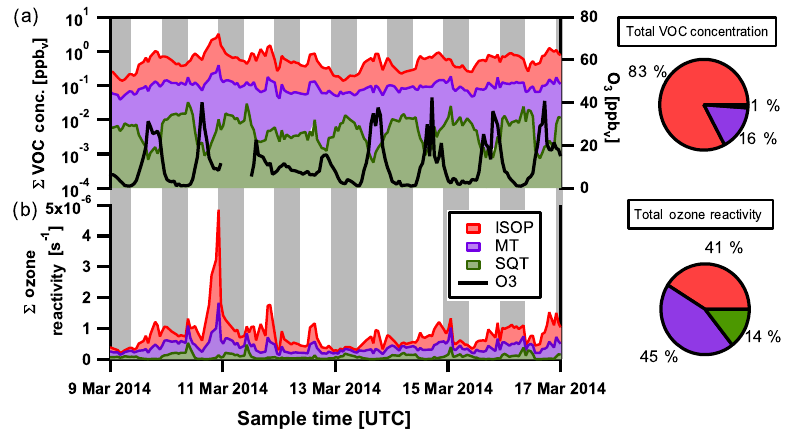
Figure 4. Wet season selected timeline of summed gas-phase VOC concentrations, isoprene (ISOP, red), monoterpenes (MT, purple), and estimated sesquiterpenes (SQTs, green) and ozone concentration (O 3 , black) in panel (a) . Average percentage contributions during the wet season for each group to total VOC concentration are also shown in the top pie chart. Panel (b) depicts the summed contribution to ozone reactivity from isoprene, monoterpenes, and sesquiterpenes. Average percentage contributions during the wet season for each VOC to total ozone reactivity are shown in the bottom pie chart. Local nighttime hours indicated in grey. Local time is − 4h relative to